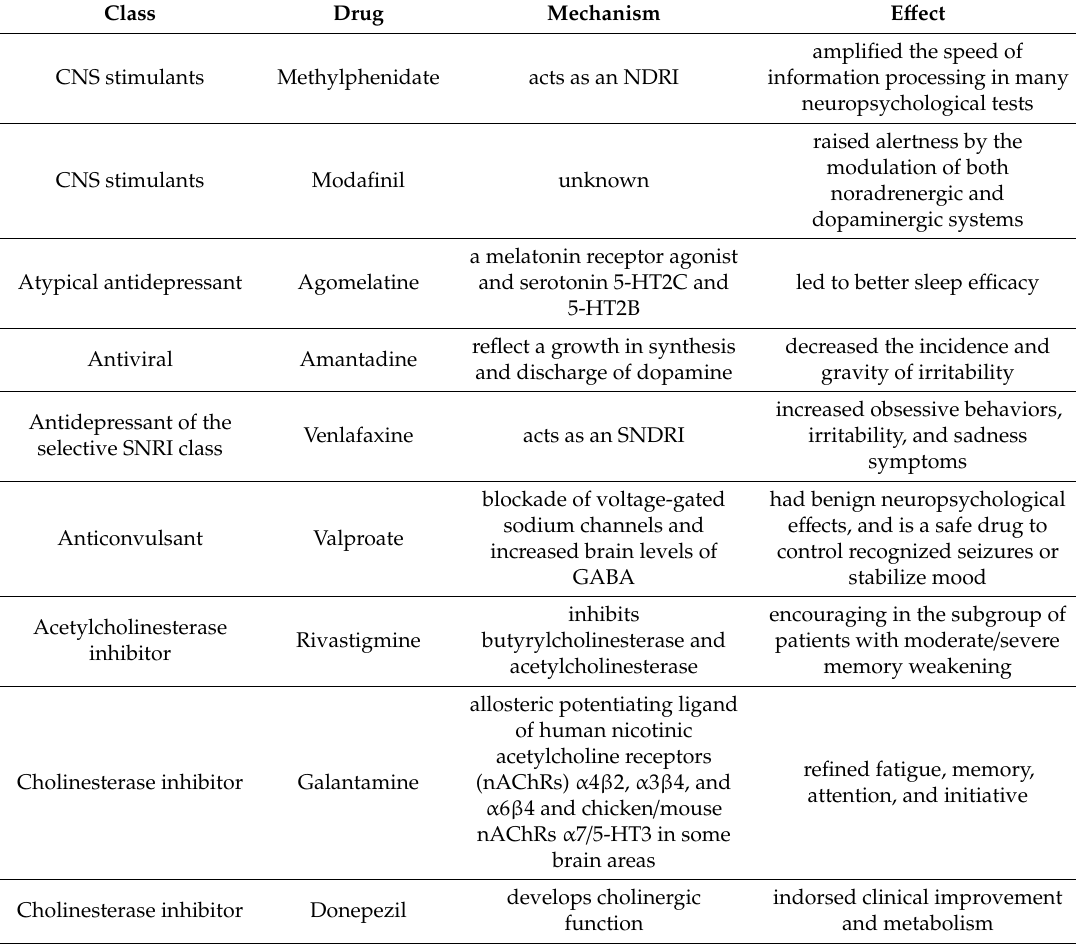
Table 4. Current drugs for neurobehavioral disorders after